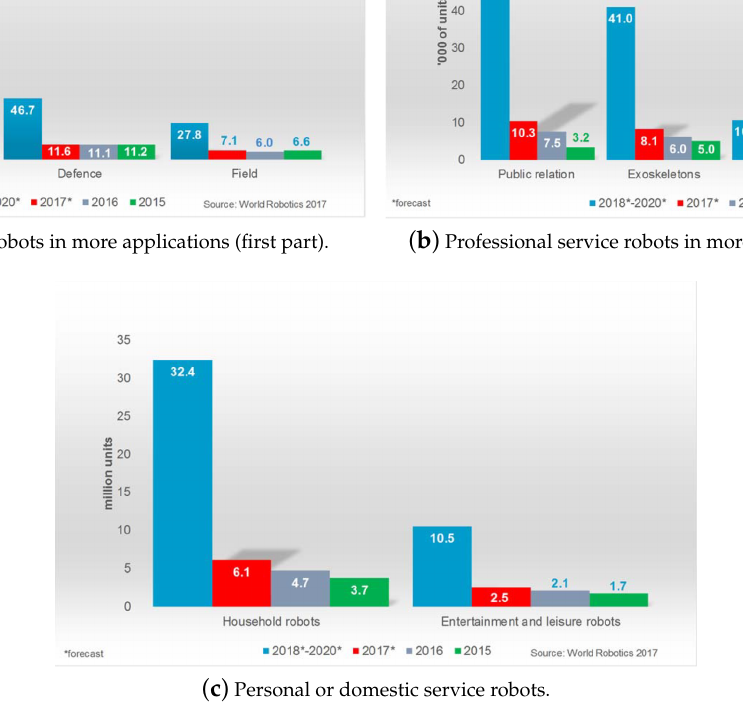
Figure 2. Unit sales 2015 and 2016, forecast 2017 and 2018–2020 for professional and domestic service robots